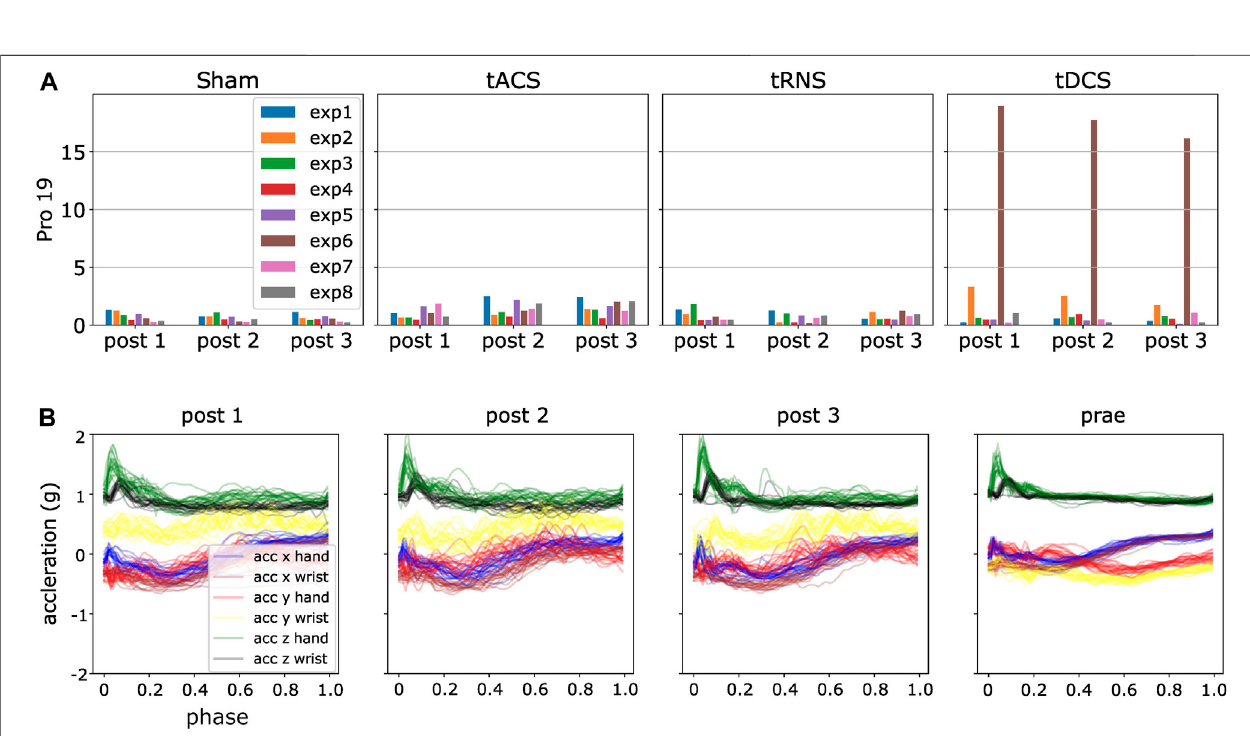
FIGURE 12 | An illustration of sliding window approach to reveal time-speci fi c difference in trajectory space. (A) Sliding window with the size of 1/10 of the total normalized time, i.e., phase between τ prae and τ post 1 from one random experiment (B) The resultant symmetric KL-divergence averaged over all six axes between two experiments in sliding window